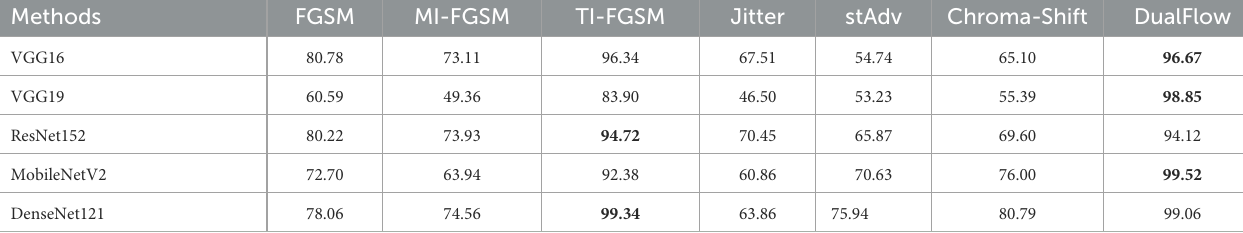
TABLE 4 Experimental results on the attack success rate of targeted attack on dataset ImageNet.